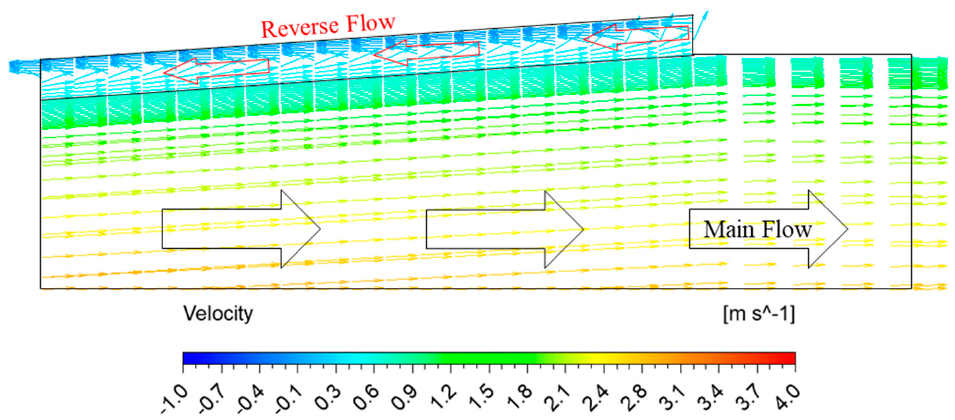
Figure 18. Velocity vectors in the AJP model with J-Groove at q = 0.5.